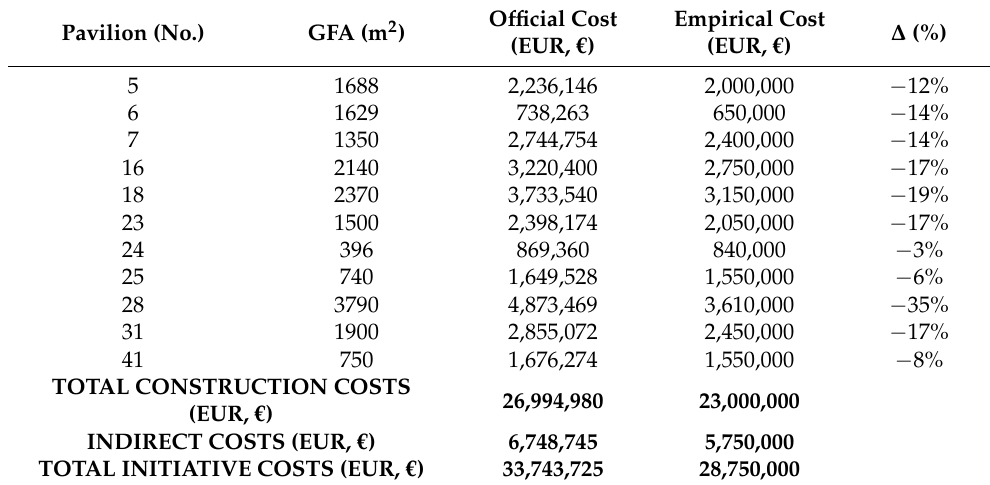
Table 3. Costs obtained by implementing an empirical procedure for the intervention of Santa Maria della Piet à monumental